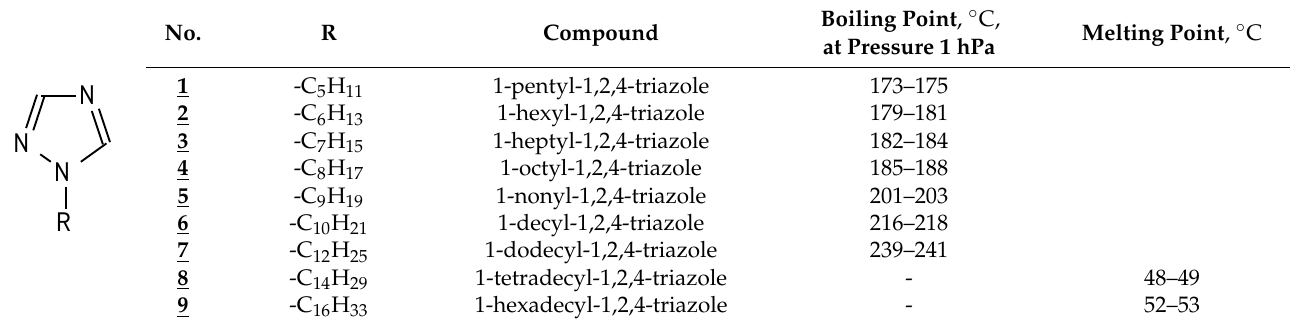
Table 1. Properties of 1-alkyl-1,2,4-triazoles used in the studies.